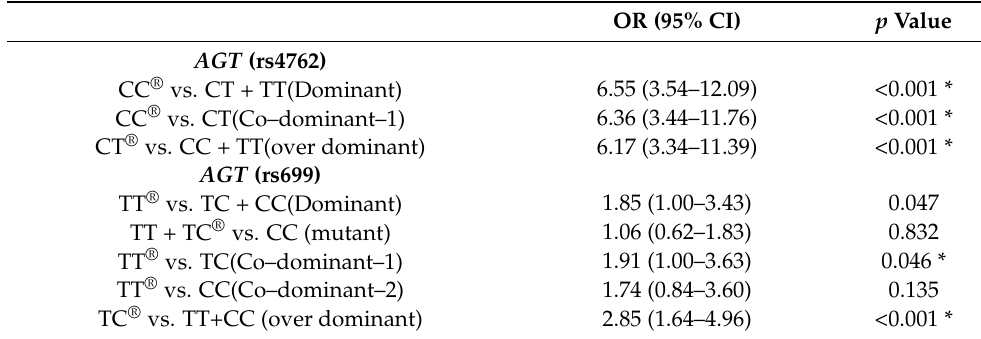
Table 5. Comparison between the two studied groups (all patients versus controls) according to AGT gene (rs4762 and rs699) polymorphism in different genetic